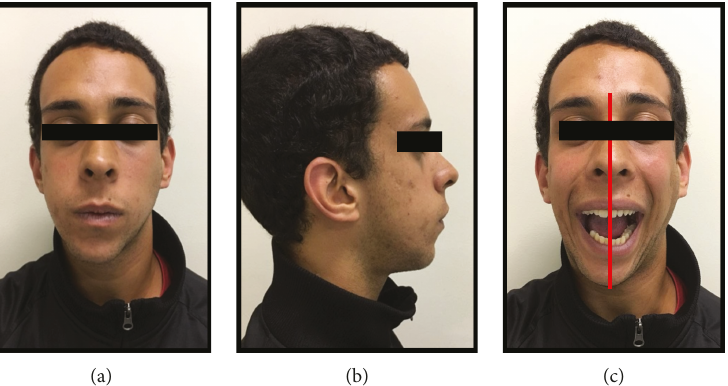
Figure 15: (a), (b), and (c) Postsurgery pictures after two years emphasizing the improvement in the facial harmony, mouth opening, and chin deviation.